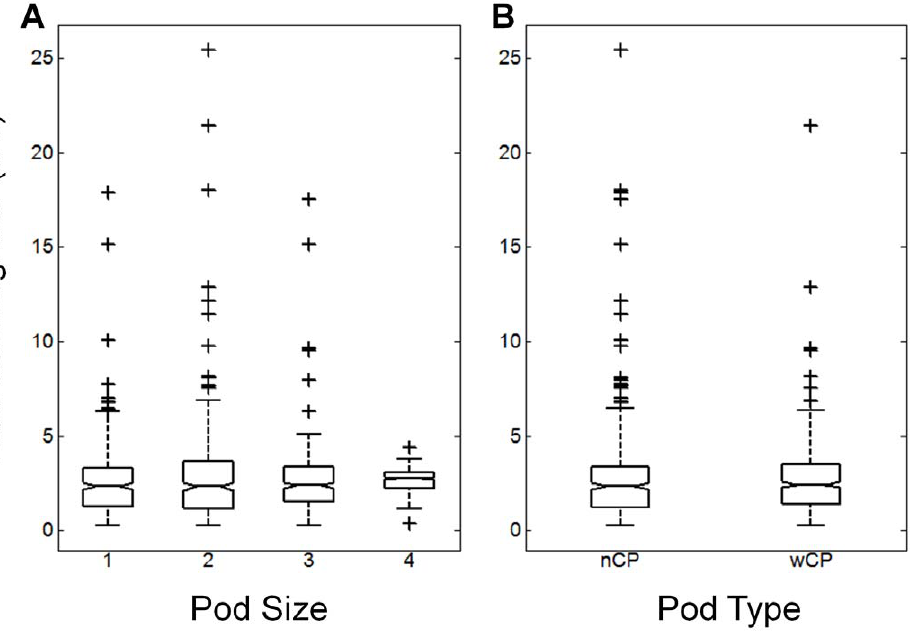
Figure 6. Boxplots comparing median nearest neighbour of A) the pod size and B) the pod type. Neither pod size or type showed significant difference in median nearest neighbour distances (Kruskall-Wallis test: pod size p=0.80, pod composition p=0.58). For pod type, ‘wCP’ are pods with calves present and ‘nCP’ are pods with no calves observed.